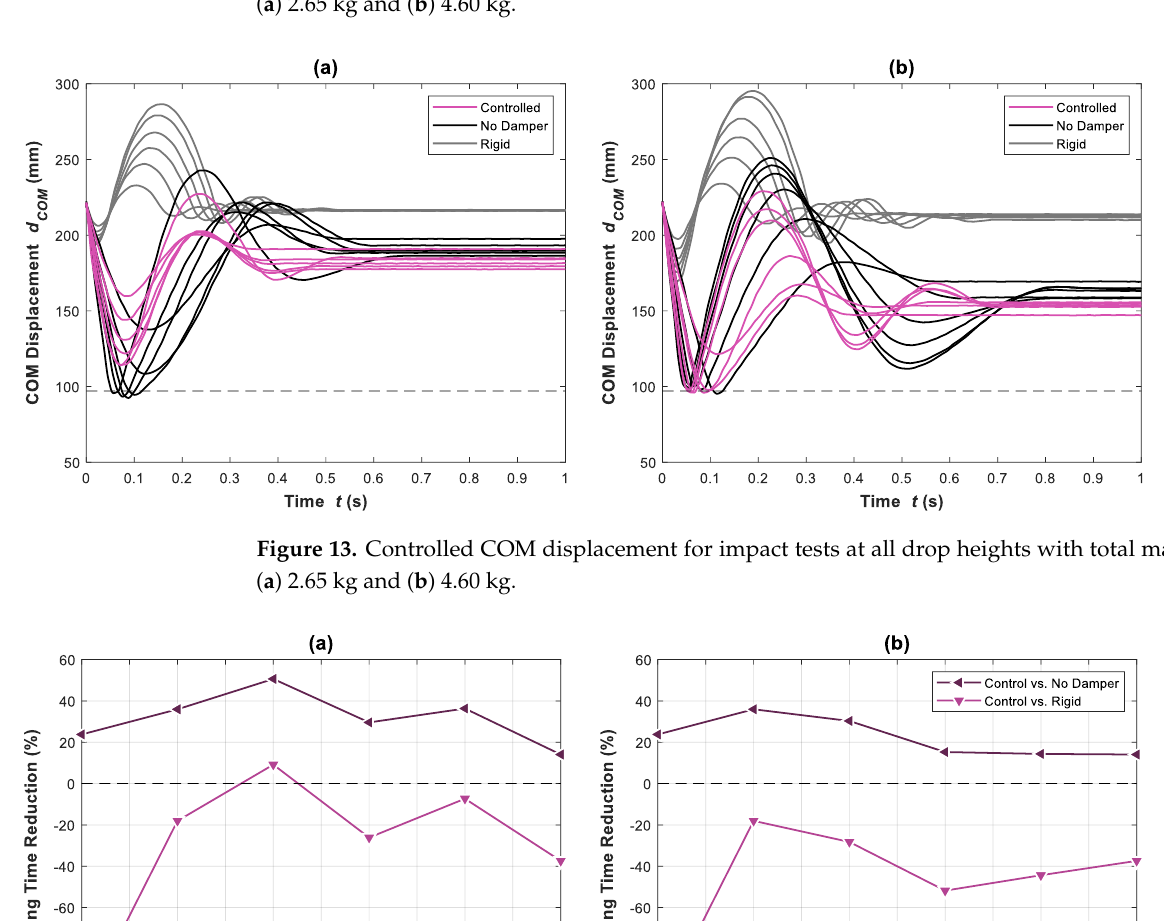
Figure 12. Controller improvement in peak impact force for impact tests with total masses of ( a ) 2.65 kg and ( b ) 4.60 kg.